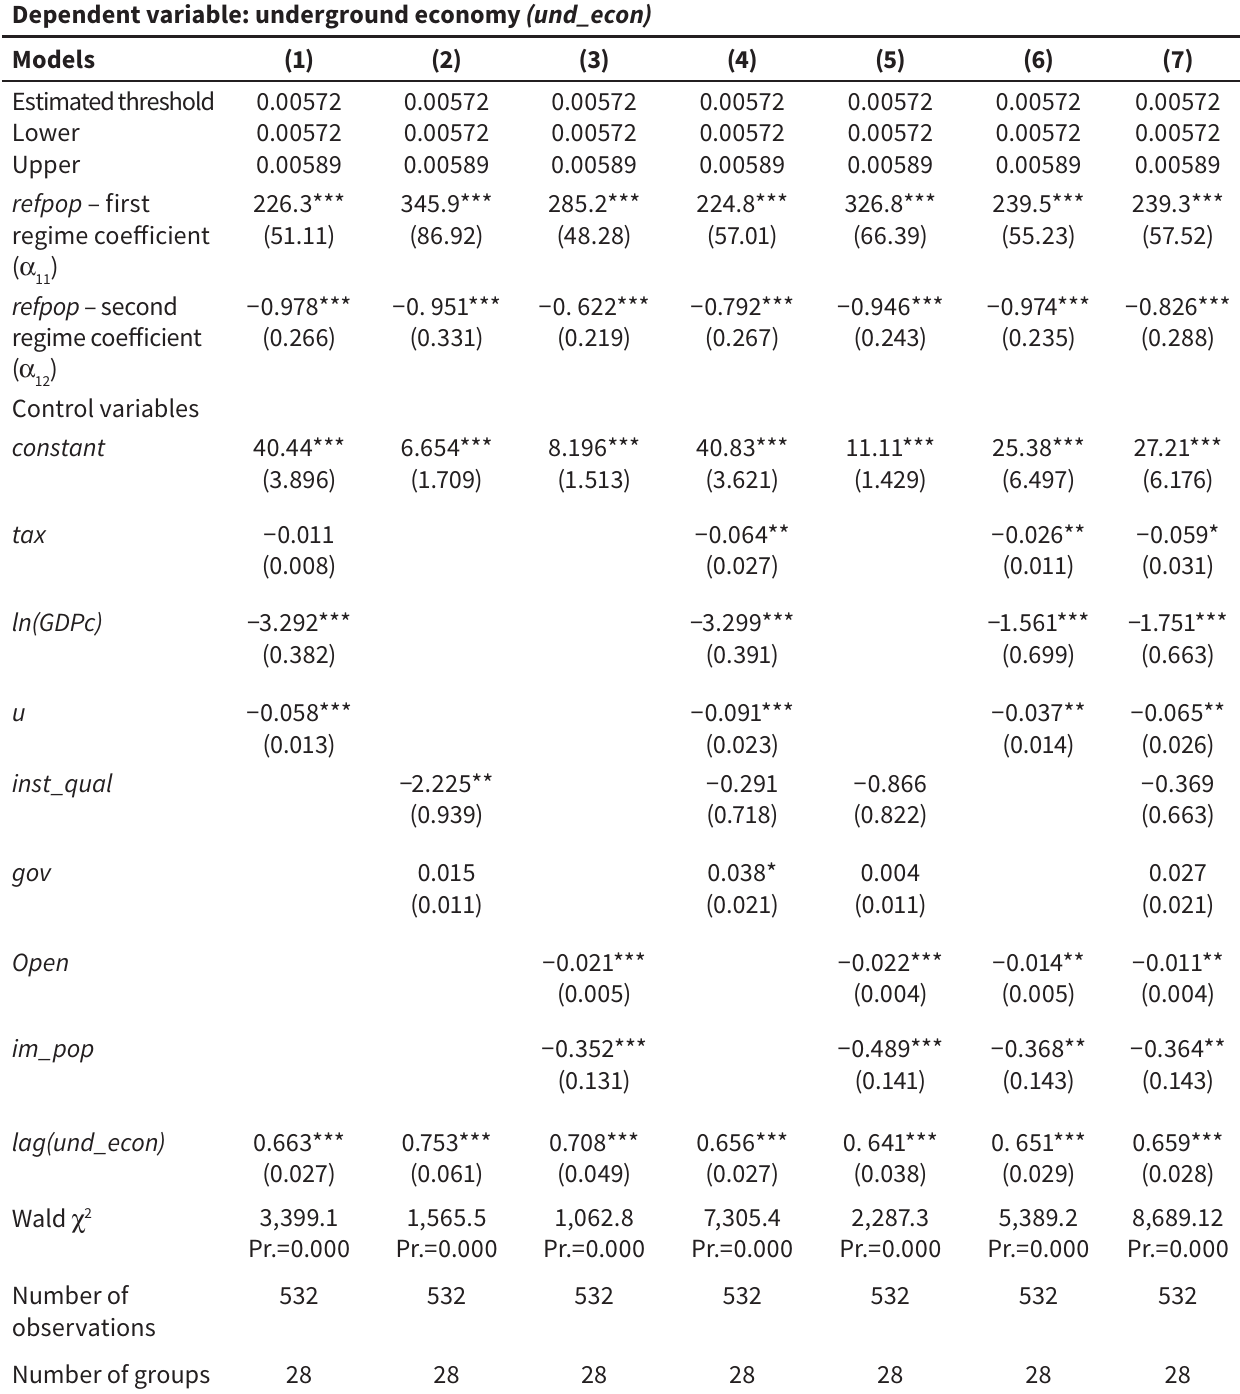
Results of single threshold